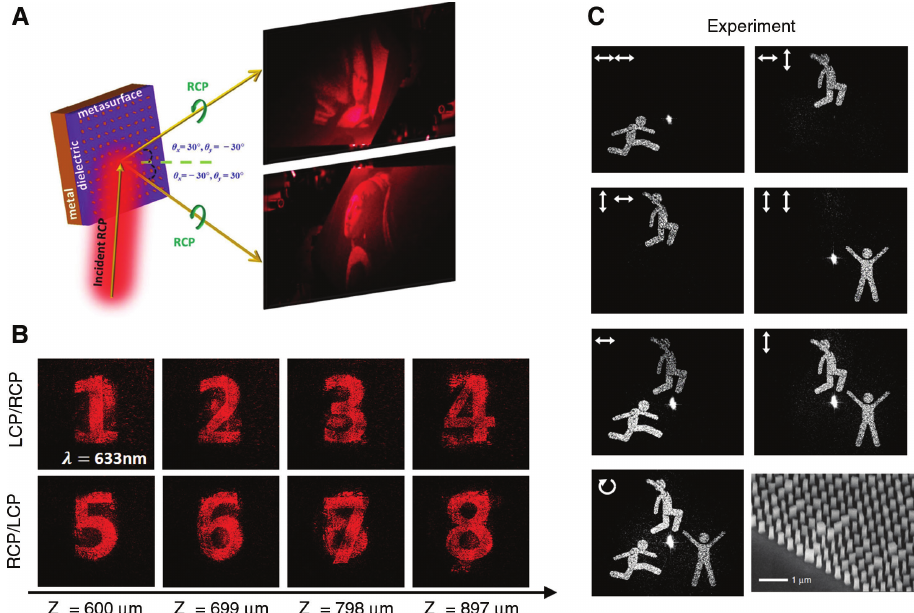
Figure 1: The holographic multiplexing of metasurfaces. (A) Schematic diagram of hybrid holographic multiplexing metasurface [49]. (B) Experimental results of broadband multiplane metasurface hologram based on the 3D Fienup algorithm [36]. (C) Experimental results of full vectorial metasurface hologram with different polarization combinations